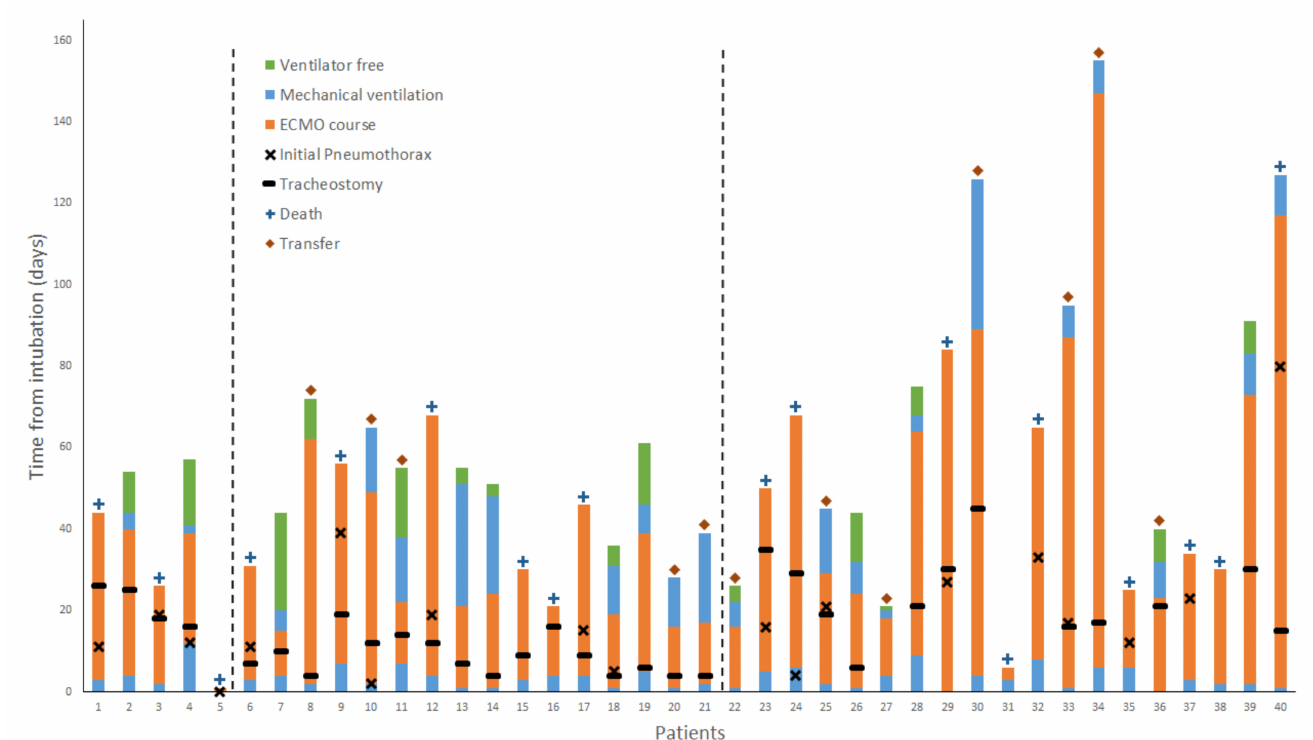
Figure 2. Hospital course of COVID-19 patients supported with veno-venous extracorporeal membrane oxygenation from the time of intubation. The diamond symbol indicates transfer out of our center, and, in the absence of a symbol above the bar, patients were discharged either home or to a rehabilitation facility. Patient 8 was on continuous trach collar, 4 days prior to ECMO decannulation. Patient 37 was extubated for 4 days while on ECMO, prior to tracheostomy. Patients before the first dashed line were cannulated in the period of “no tracheostomy” policy. Patients in between dashed lines were cannulated in the period of “early tracheostomy” policy. Patients after the second dashed line were cannulated in the period of “tracheostomy when no proven coagulopathy”